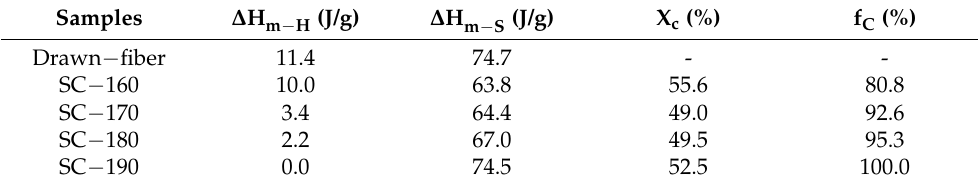
Figure 3. DSC heating curves of PLLA/PDLA fiber. Table 2. Thermal parameters of drawn − fiber and SC − PLA fiber.